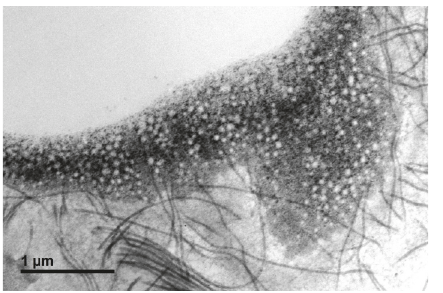
Figure 2: Electron microscopy showed tubular aggregates(x